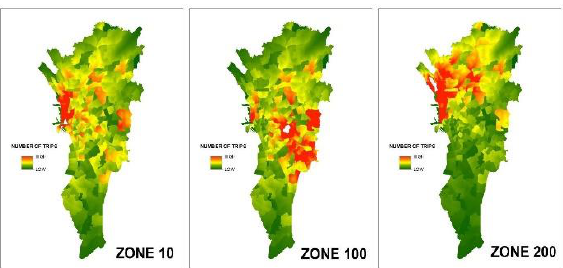
Figure 8. Sample Trip Distribution Raster